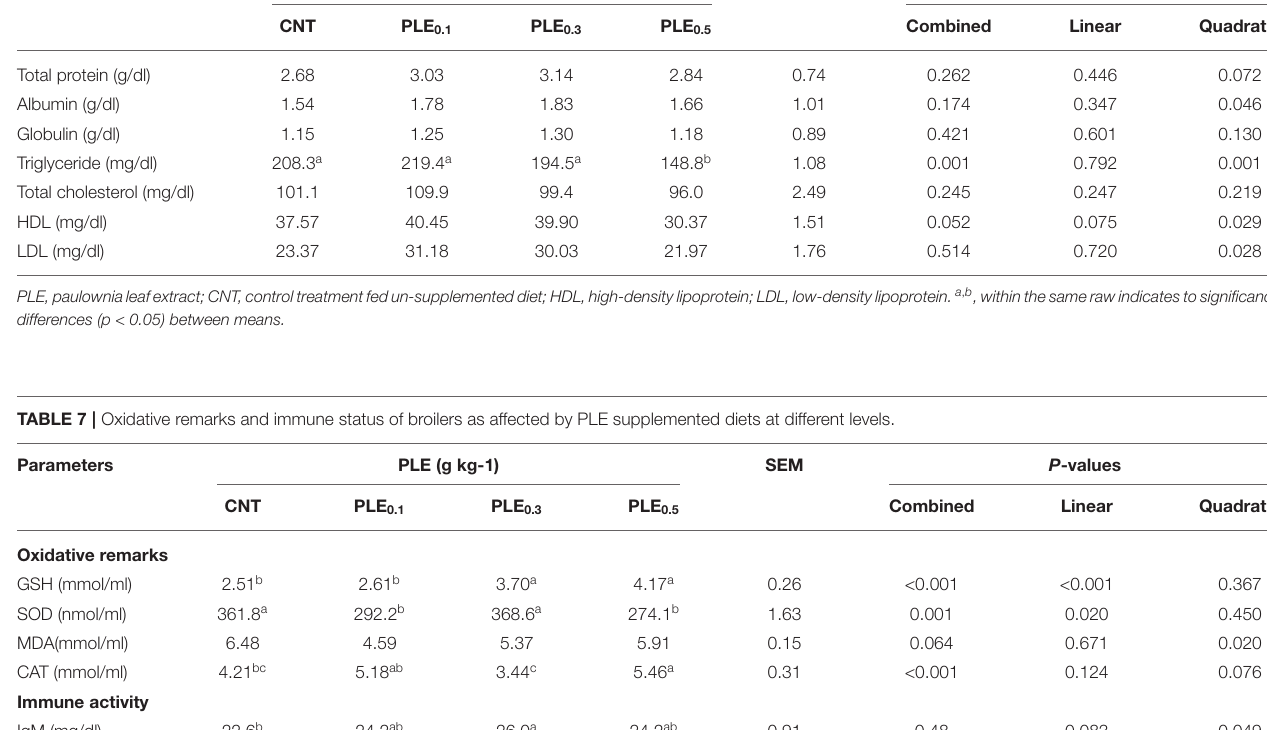
TABLE 6 | Blood biochemical measurements of broilers as affected by PLE supplemented diets at different levels. Parameters